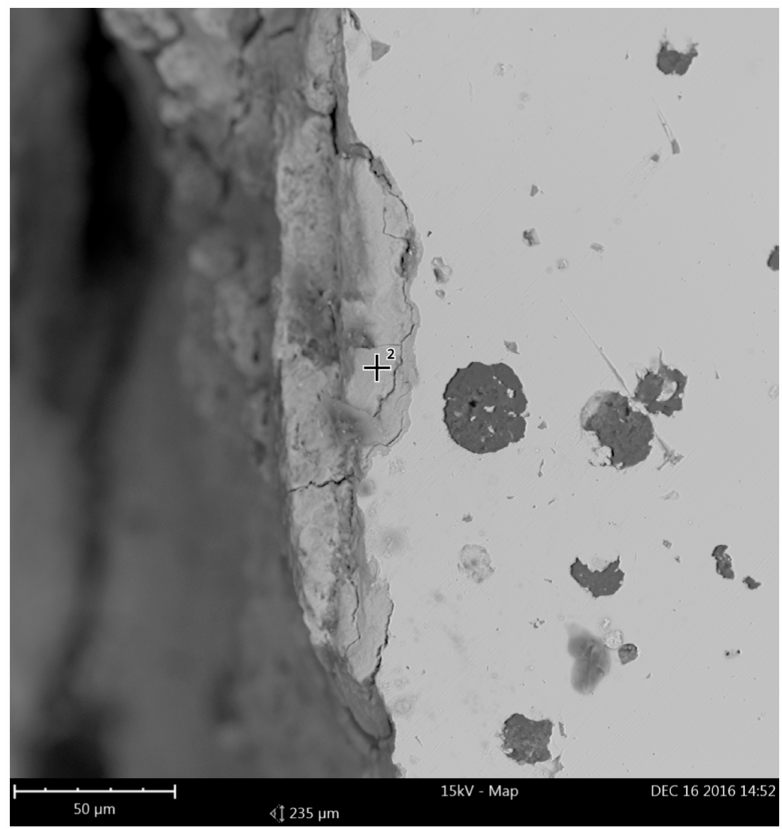
Figure 3. Sectional view of the surface layer of the casting with the fayalite precipitate marked with the number 2.